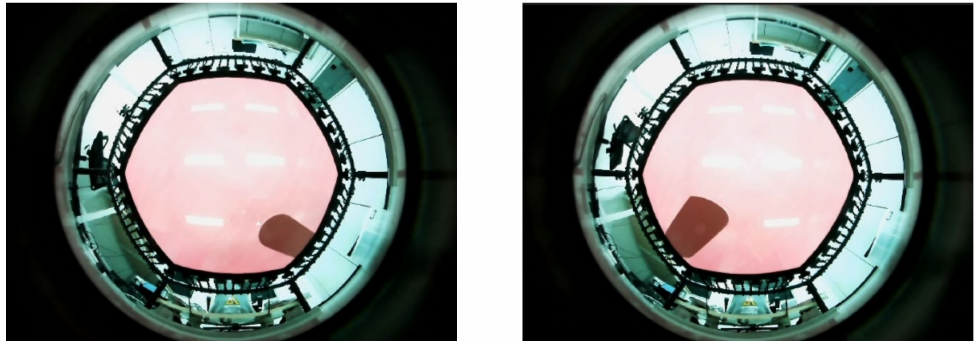
Figure 11. Interference image between the manipulator and the